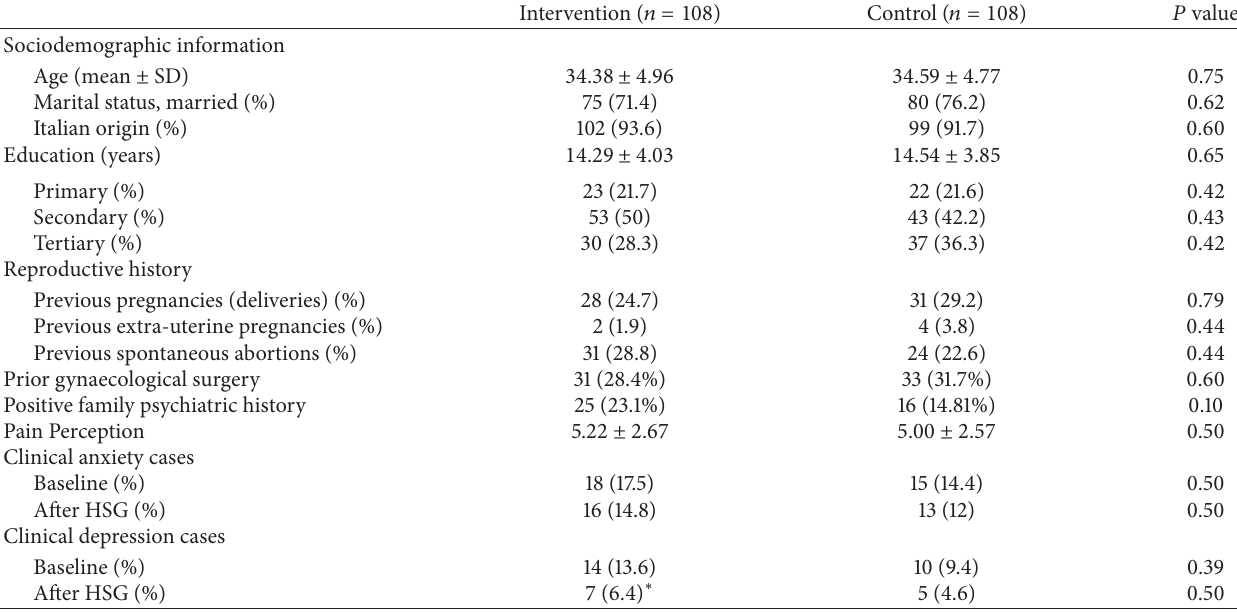
Table 1: Baseline sociodemographic and clinical characteristics of intervention ( 𝑛 = 108 ) and control ( 𝑛 = 108 ) groups. Intervention ( 𝑛 = 108 ) Control ( 𝑛 = 108 ) 𝑃 value Sociodemographic information